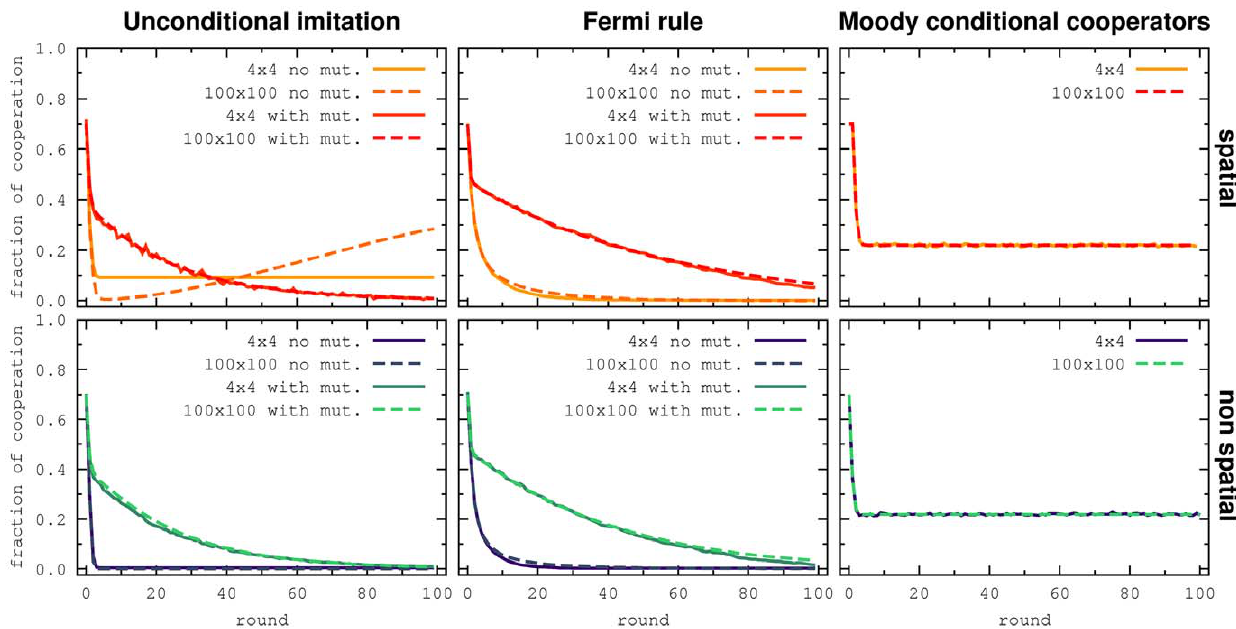
Figure 5. Simulations for different update mechanisms. Top figures are for the spatial structure and the bottom ones are for non spatial structure. Left to right: unconditional imitation, Fermi and moody conditional cooperators. We see that, for this payoff matrix, the only update mechanism where the spatial structure is relevant is unconditional imitations without random strategy exploration.